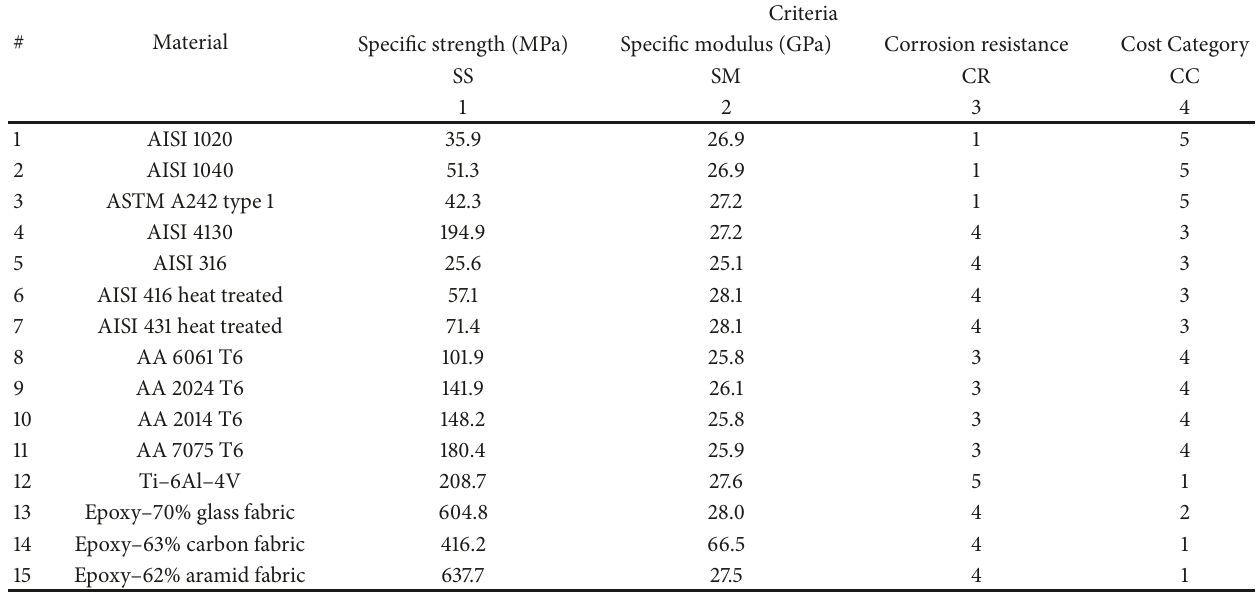
Table 3: Decision matrix for selecting material for a sailing boat